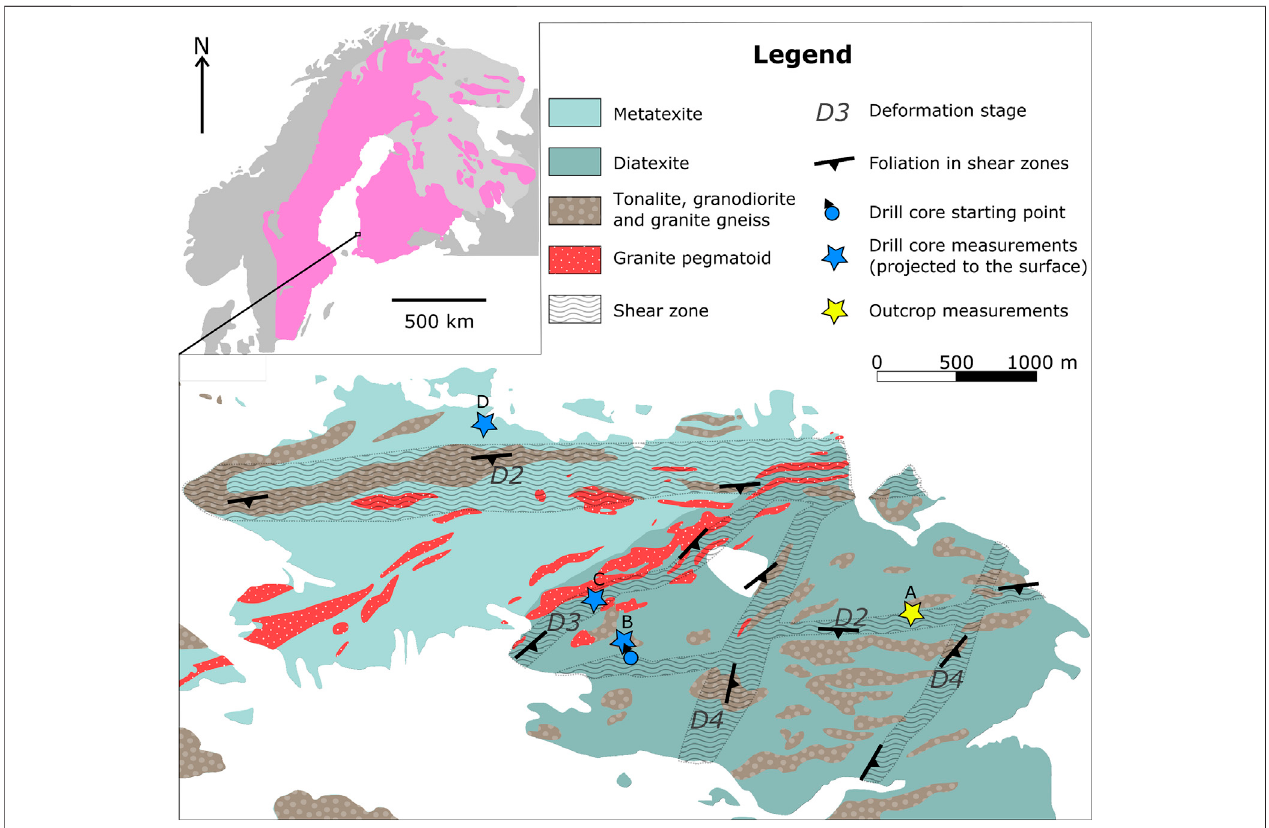
FIGURE 2 | Map of the Olkiluoto island. Upper left: location of the site within the Svecofennian rocks in the Baltic Shield (based on Koistinen et al., 2001). Main picture: simpli fi ed bedrock map of Olkiluoto, after Aaltonen et al., 2016. In general, the Olkiluoto migmatite is more diatexitic to the east and metatexitic to the west, although the transition is more gradual than indicated in the map. Strain was concentrated into the ductile shear zones that divide the island into several less-intensely deformedstructuralblocks.ShearzonesorientedEtoWaretheoldest,andtheyoungertheshearzone,themoreNNE-SSWorientationithas.Themeasureddrill- core sections are projected to the corresponding structural units on the surface according to Hartley et al. (2017). Labels A-D correspond to the sections in Figure 4 .